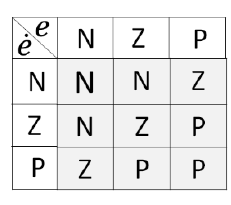
Figure 5. Table of fuzzy